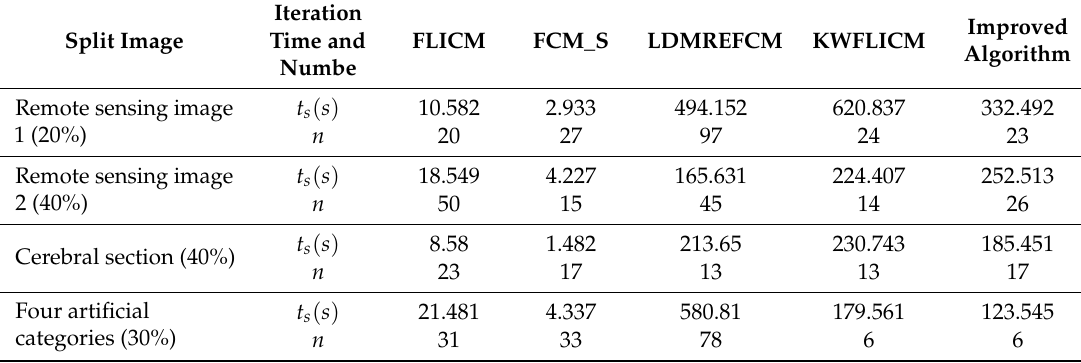
Table 6. Operation time and number of iterations for each algorithm.